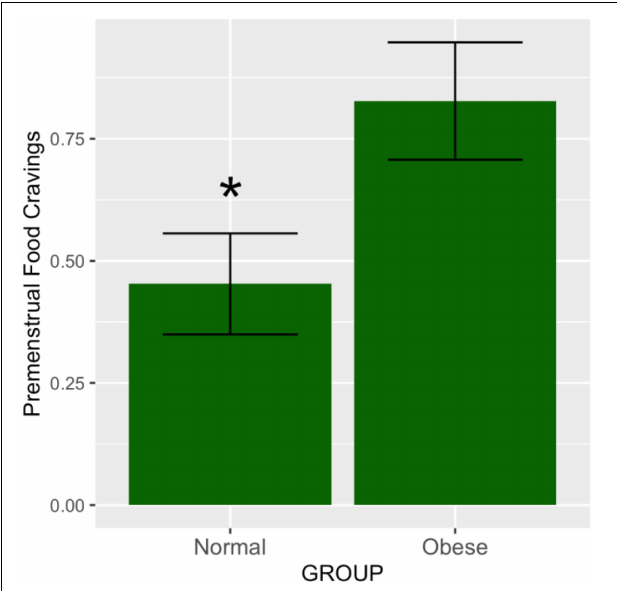
FIGURE 1 | Premenstrual food cravings according to abdominal obesity groups. The means and SEM represent food cravings scores in the premenstrual vs. the mid-follicular subphase, adjusted for total variance across the entire menstrual cycle. As demonstrated by the ANOVA test, the obese group had significantly higher ratings of food cravings in the premenstruum compared to the non-obese group ( p = 0.02). * p ≤ 0.05.